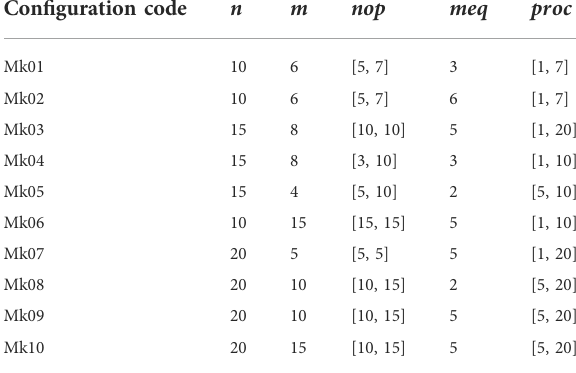
TABLE 6 Hyperparameter values of Algorithm